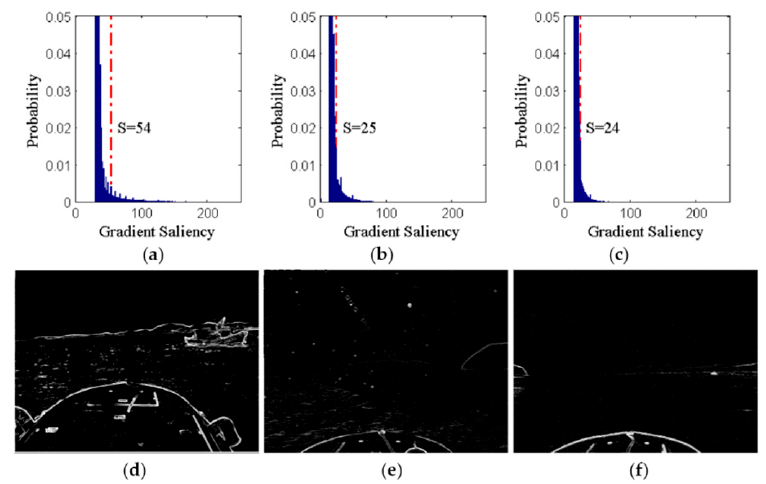
Figure 4. Histograms of gradient saliency and saliency list images. ( a – c ) are histograms of gradient saliency; ( d – f ) are saliency list images.